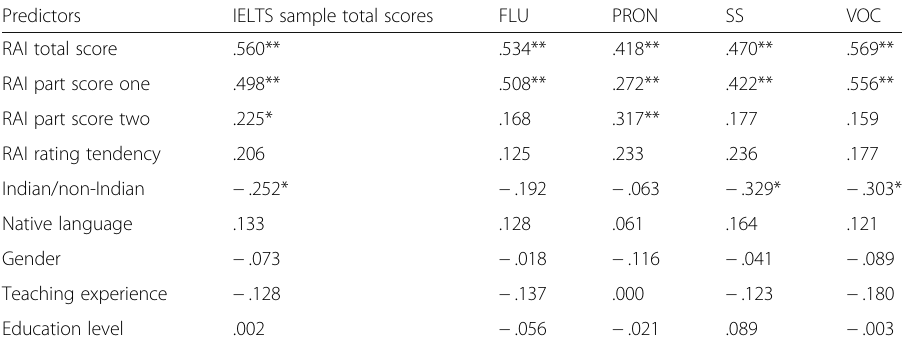
Table 5 Correlations among IELTS tasks scores, attitude scores, and background variables